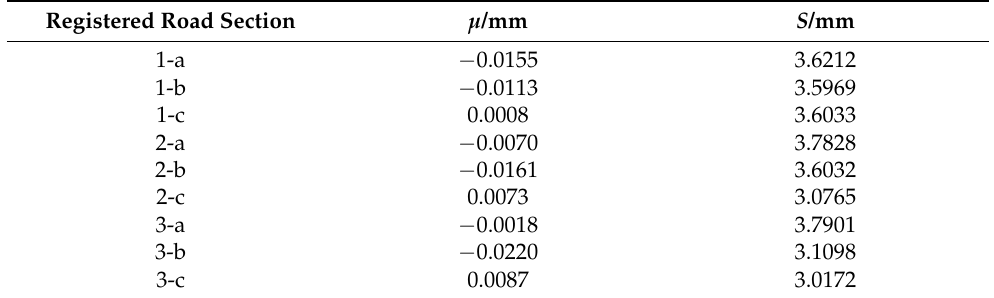
Table 4. Normally distributed fitting parameters for the registered point cloud elevation difference.